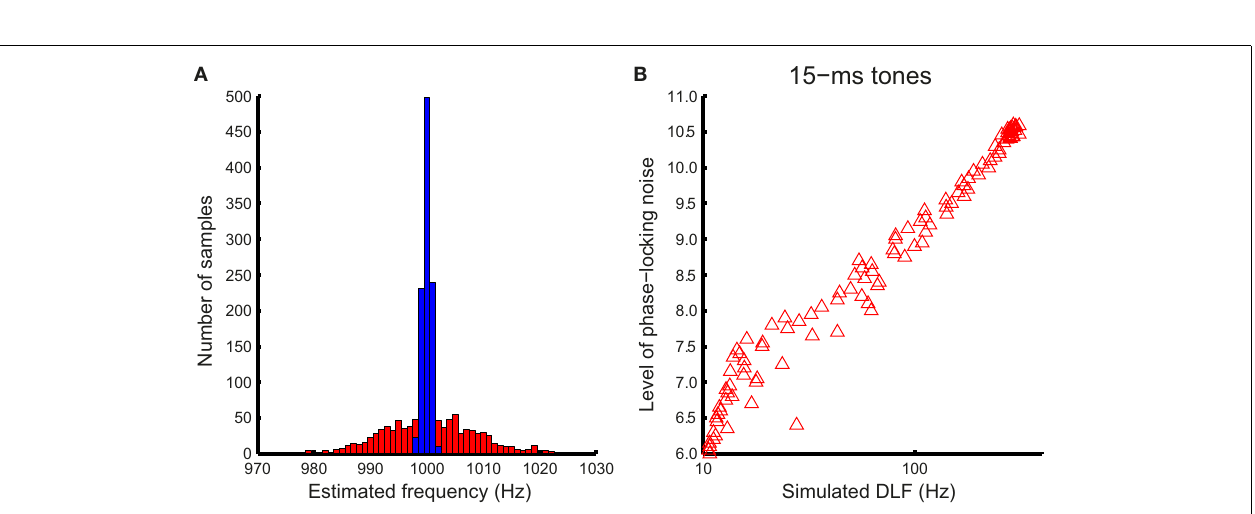
FIGURE 5 | Simulating the relationship between DLFs and phase locking noise. (A) An example of estimated frequency distribution with phase locking noise.The distribution of estimated frequency for an example noise level (8.8) and the maximum integration window (50ms) for the 100-ms 1-kHz tone (blue